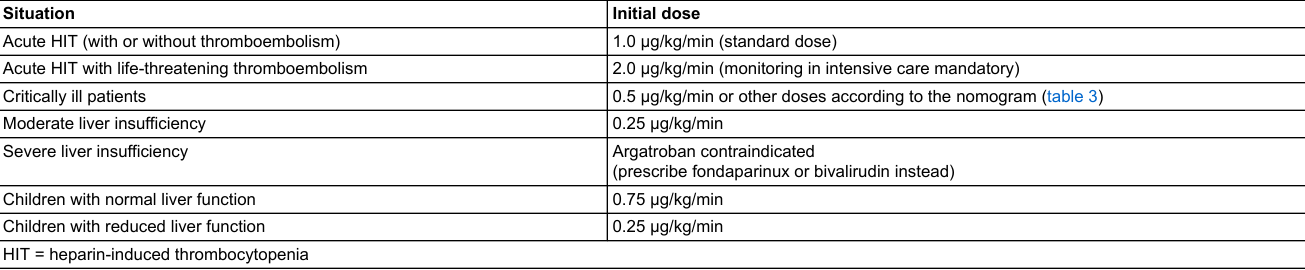
Table 2: Initial dose of argatroban in various clinical situations. Situation Initial dose Acute HIT (with or without thromboembolism) Acute HIT with life-threatening